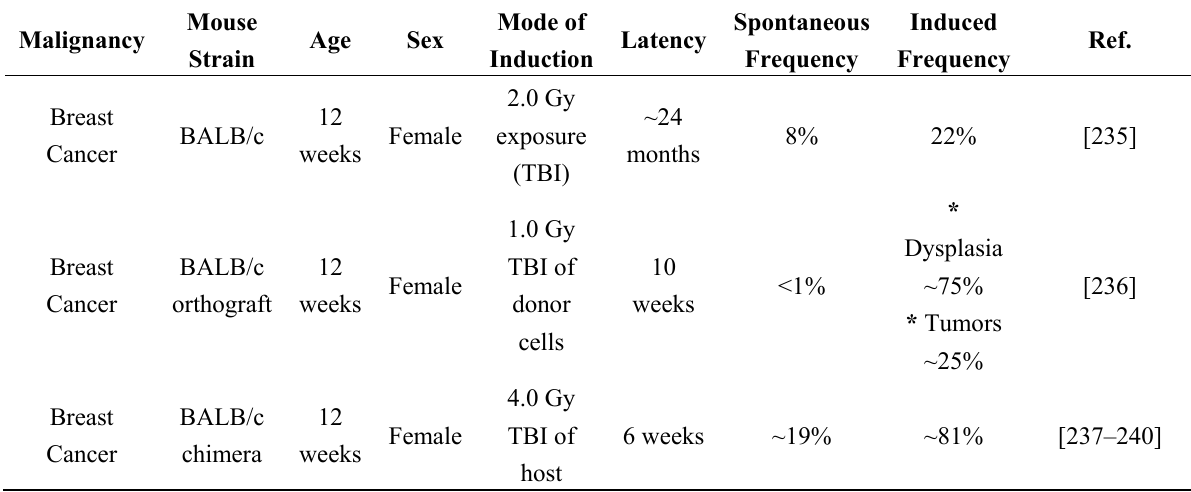
Table 6. Induction of breast cancer in mice with low-LET ionizing